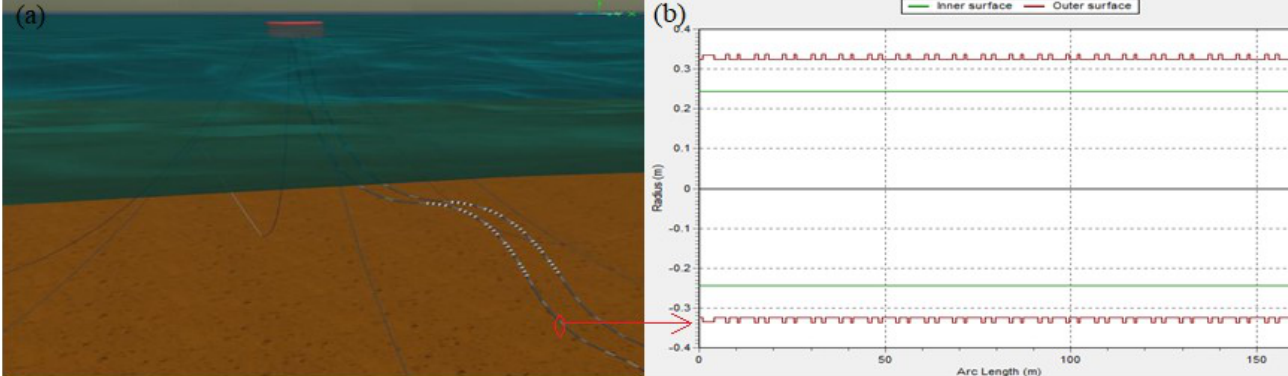
Figure 7. Numerical hose model in Orcaflex 11.0 f showing ( a ) CALM Buoy Lazy-S configuration showing mooring lines and submarine hoses, and ( b ) Submarine Hose Profile showing the radii for inner and outer surfaces .